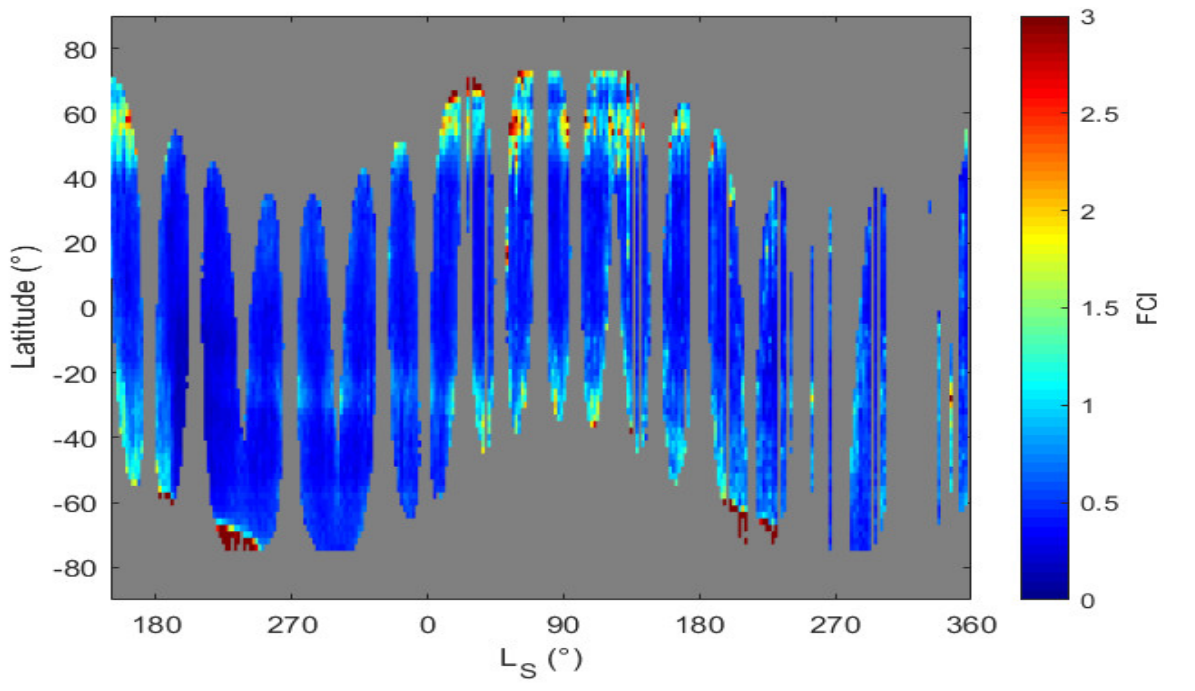
Figure 4. Latitudinal-seasonal map of FCI. Observations cover MY34, from L S = 150° to 360°, and all MY35.